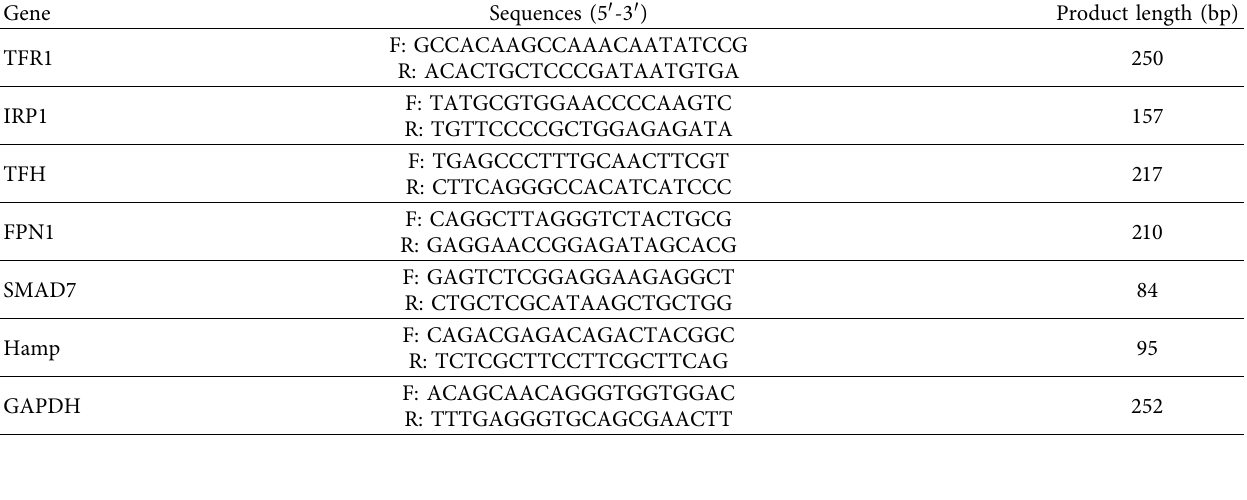
Table 1: qPCR primer sequences.